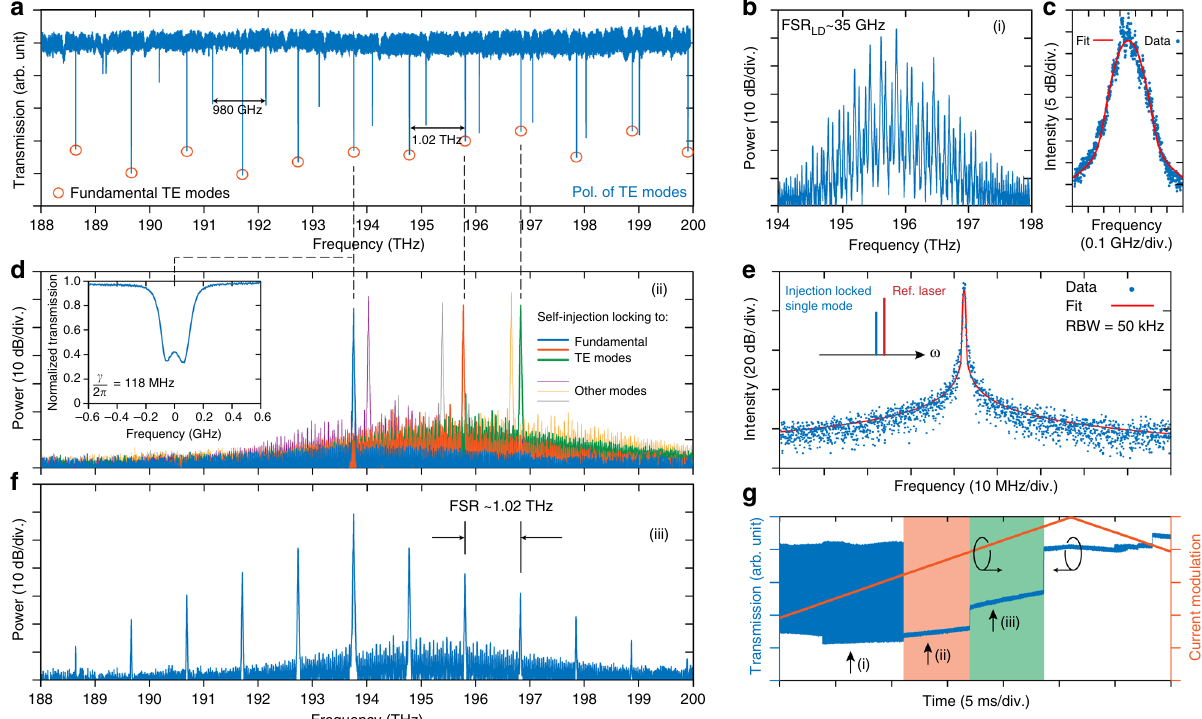
Fig. 2 Electrically pumped soliton microcomb via laser injection-locked soliton formation. a Transmission spectrum of a Si 3 N 4 microresonator of 1.02 THz free spectral range (FSR), featuring two sets of resonances: the fundamental transverse electric (TE) mode family (marked by red circles) and one high- order TE mode family. b The laser spectrum of the multi-frequency laser diode chip used in this experiment, corresponding to state i in g . c Measured and fi tted heterodyne beat signal between the free running laser diode and a narrow linewidth reference laser (Toptica CTL1550, short-time linewidth ~10 kHz), showing 60 MHz full-width at half-maximum (FWHM) of Voigt pro fi le. d (state ii in g ): Spectra of single longitudinal mode that is injection locked to a selected resonance of the microresonator. f (state iii in g ): Spectrum of the Kerr frequency comb that stems from the laser injection locking. Inset: One resonance of the fundamental TE mode showing mode splitting due to backscattering, with the estimated 118 MHz coupling strength γ forward and backward propagating modes. e Heterodyne beat signal between the injection-locked laser and a narrow linewidth reference laser. The measured beat signal is fi tted with Voigt pro fi le with FWHM ~186 kHz (cf. Methods). RBW: Resolution bandwidth. g Typical transmitted power trace measured at the chip output facet, by current modulation imposed on the laser diode, in which different states are marked: (i) noisy, multi-frequency lasing without injection locking; (ii) laser injection locking to a microresonator resonance, and simultaneous formation of low-noise single-longitudinal-mode lasing (the orange region); (iii) formation of Kerr frequency comb (the green